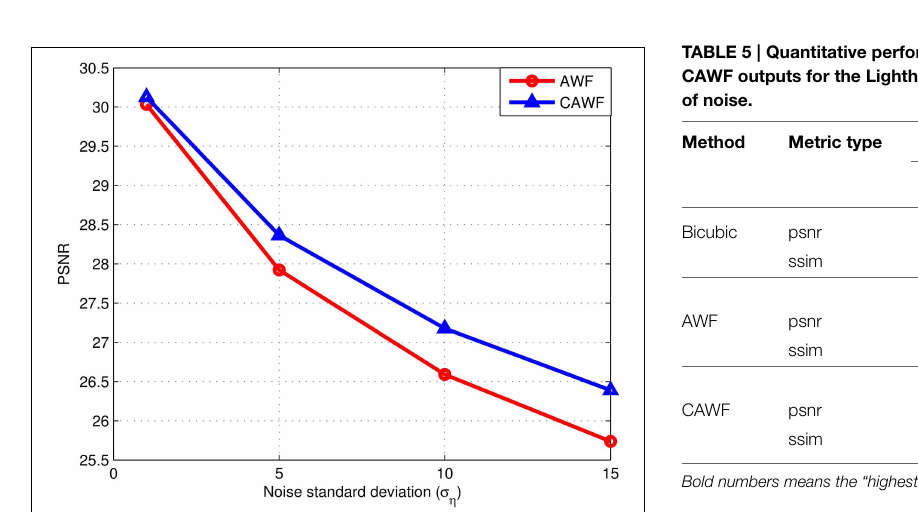
FIGURE 11 | The SSIM for AWF, CAWF, and the bicubic outputs with different levels of noise. (A) σ η results are obtained with M